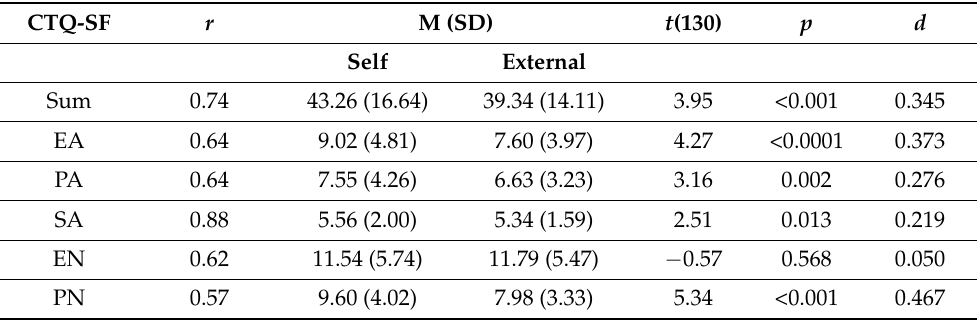
Table 4. Mean Differences between CTQ Self-Assessment and External Assessment within the Criminal Responsibility Group.